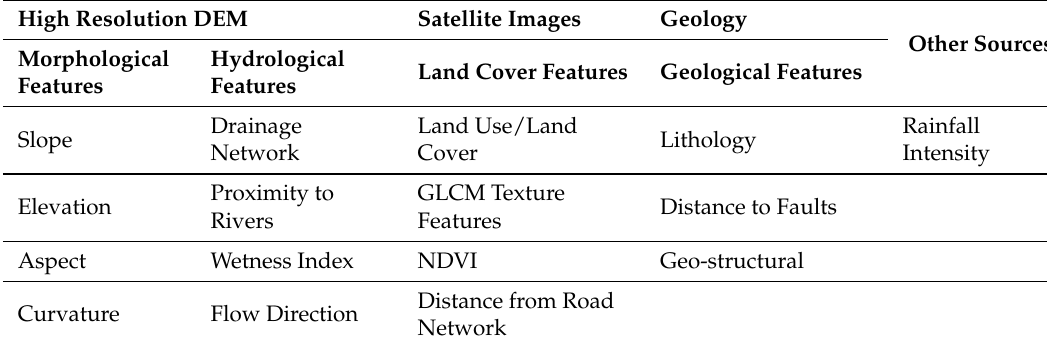
Table 1. Some of the commonly used features used in landslides mapping. This list should not be considered complete.